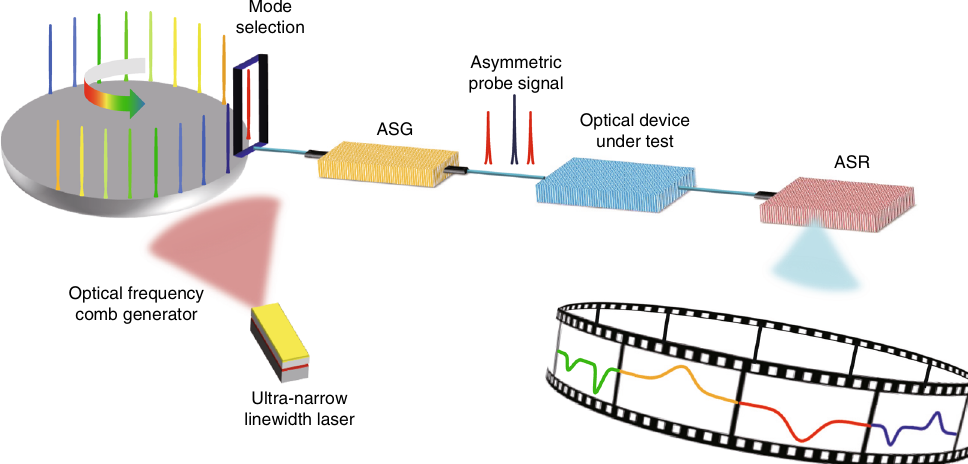
Fig. 1 Principle of the optical vector analysis using an optical frequency comb. ASG, asymmetric optical probe signal generator; ASR, asymmetric optical probe signal receiver. The mode-selection module selects a comb line from the OFC signal to generate an asymmetric probe signal by the ASG. After the ODUT, the information carried by the asymmetric probe signal is extracted by the ASR. Changing the wavelength of the mode-selection module, responses in all wavelength channels can be obtained